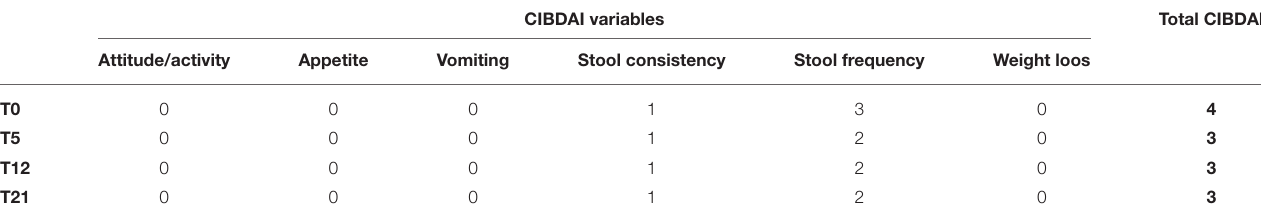
TABLE 1 | Evolution of the canine inflammatory bowel disease activity index (CIBDAI) score of the patient after